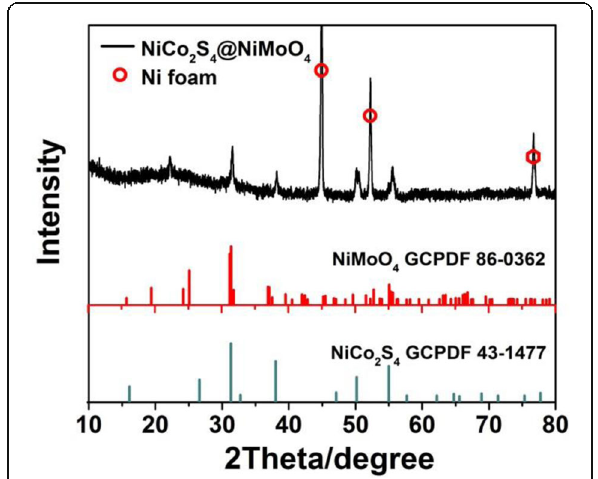
Fig. 2 XRD pattern for NiCo 2 S 4 @NiMoO 4